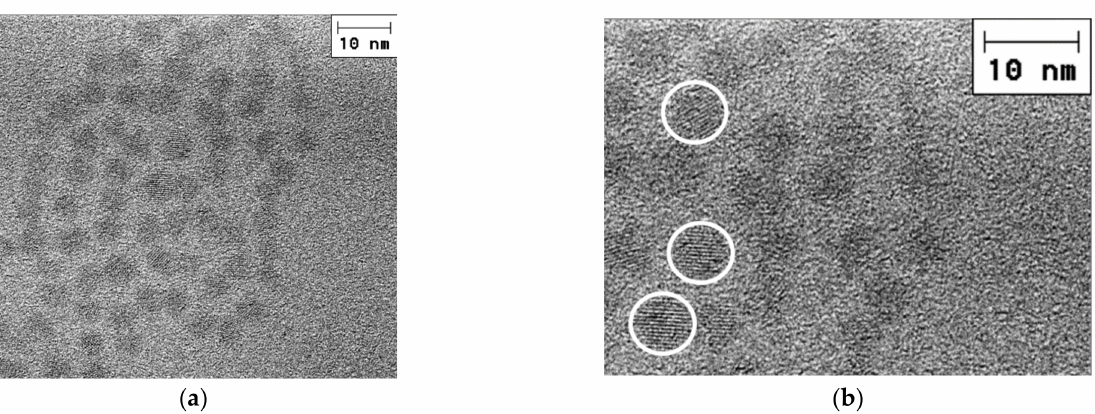
Figure 5. ( a ) HRTEM image of CdSe NCs lying on Si substrate. ( b ) Zoomed area of HRTEM image ( a ) with some NCs highlighted by white circles illustrating the crystalline structure of